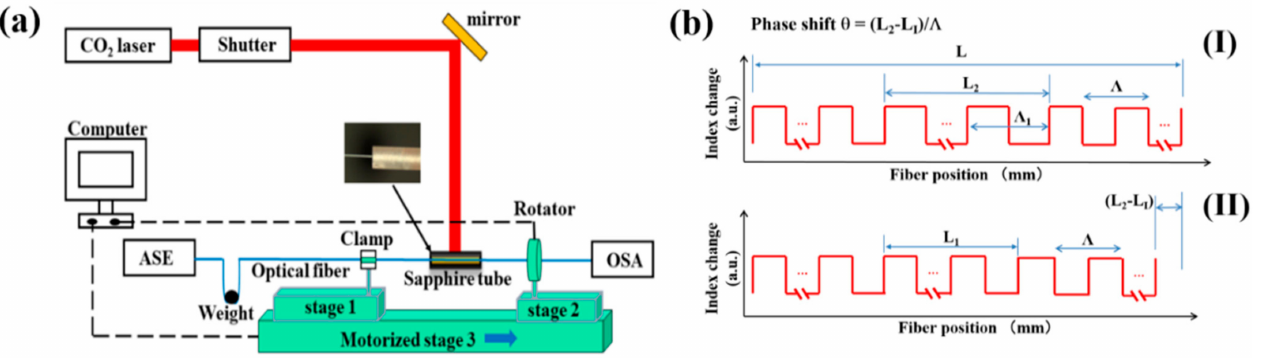
Figure 29. ( a ) Sapphire tube and CO 2 laser-based processing platform for HLPG fabrication. ( b ) Prin- cipal scheme for formation of a phase-shifted HLPG. Adapted with permission from ref. [165]. © The Optical